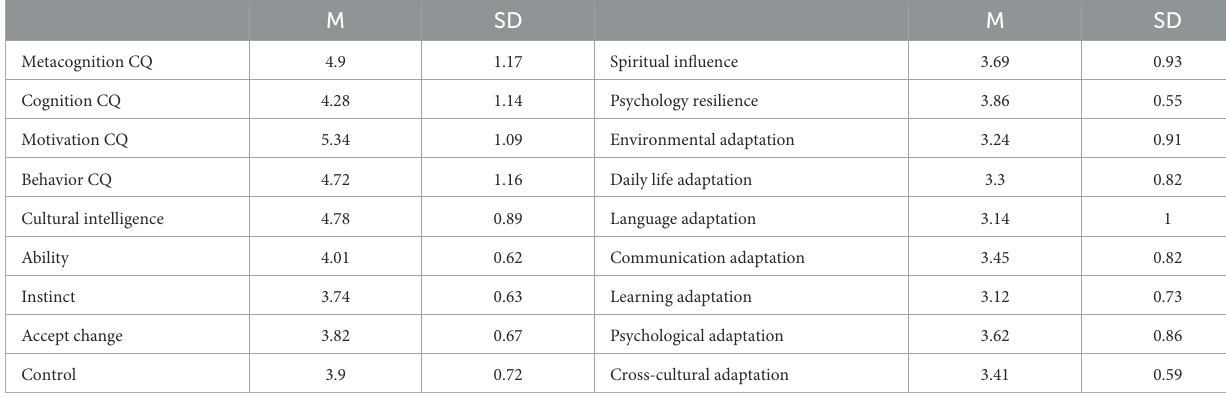
TABLE 2 Descriptive statistics of variables and dimensions ( n = 624, M ± SD).